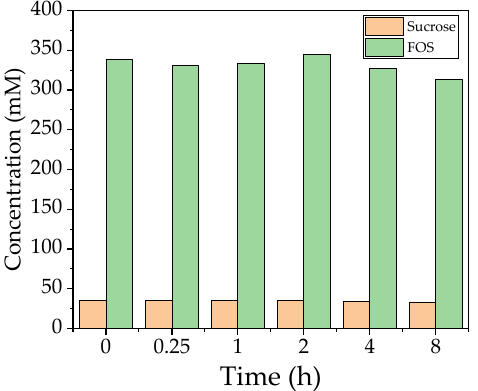
Figure 7. Concentration of total FOS and sucrose in the catalysis reaction during filtration.